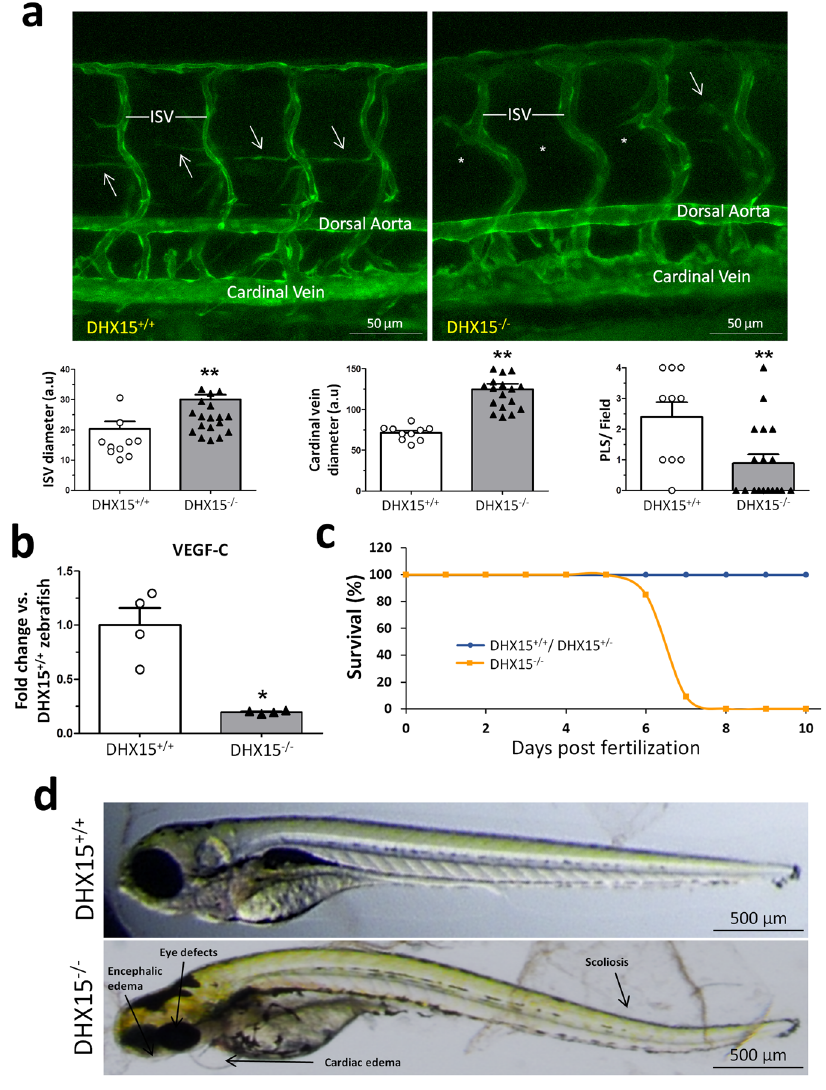
Fig. 3 Characterization of embryonic vascular anomalies associated with DHX15 gene de fi cient in zebra fi sh. a Representative vascular images of DHX15 + / + and DHX15 − / − larvae at 5 day post fertilization (dpf) revealing a reduced formation of the parachordal line (arrows). Asterisks denote the absence of these vascular structures in DHX15 − / − animals. Quanti fi cations of cardinal vein diameter, intersegmental vessels (ISV), and number of parachordal lymphangioblast strings (PLS) are shown in the graphs. ** p < 0.01 vs. wild-type zebra fi sh, unpaired two-tailed Student ’ s t -test ( n = 10 and n = 18 for the DHX15 + / + and DHX15 − / − conditions, respectively). Arbitrary units: a.u. b RNA extraction of zebra fi sh embryos at 4 dpf from either wild- type or DHX15 knockout larvae was performed. mRNA expression was analyzed by RT-qPCR. The graph shows the different expression levels of the VEGF- C gene in the DHX15 + / + and DHX15 − / − conditions. mRNA levels are shown as fold change relative to HPRT mRNA levels. *p < 0.05 vs. wild-type unpaired two-tailed Student ’ s t -test ( n = 4 biologically independent samples for each condition). c Survival assessment assay. The graph shows the larvae survival rate through the fi rst 10 dpf according to their different genotype ( n = 15 zebra fi sh larvae for each condition). d Representative images comparing wild-type and DHX15 − / − larvae at 7 dpf where morphological defects including encephalic and cardiac edema, scoliosis, and impaired neural/eye growth are evident. All bar graphs are presented as mean ±